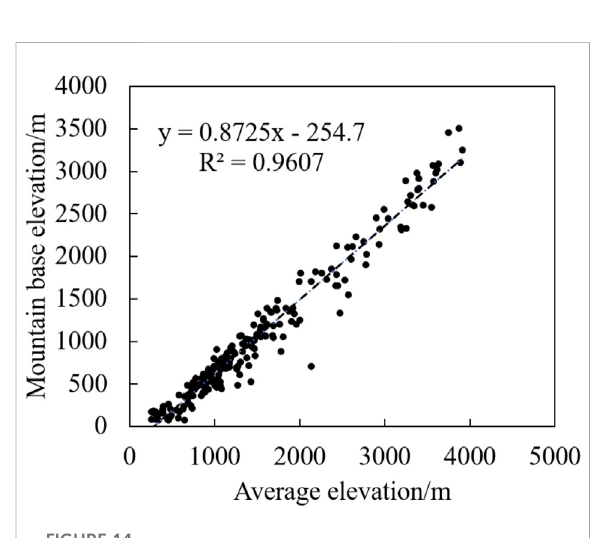
FIGURE 14 Scatter plot of the mean altitude and base elevation in the Qinling-Daba